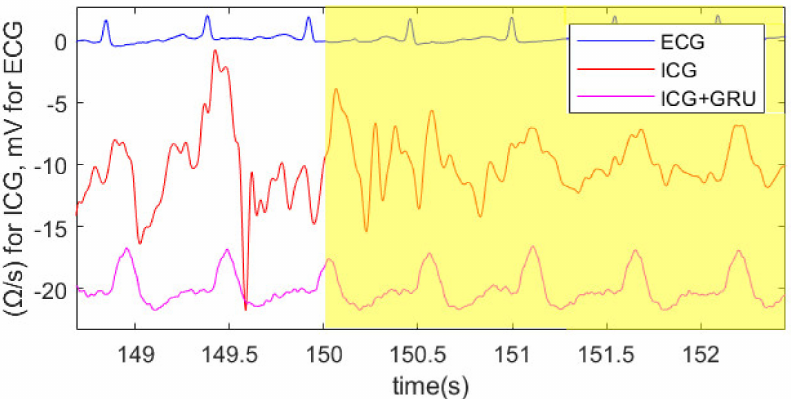
Figure 14. ECG, ICG, and processed ICG with GRU at the transition from the exercise part to the first break (marked yellow) for subject 6. ICG and the processed ICG signal have an offset of − 10/ − 20 Ohm per second ( Ω /s),